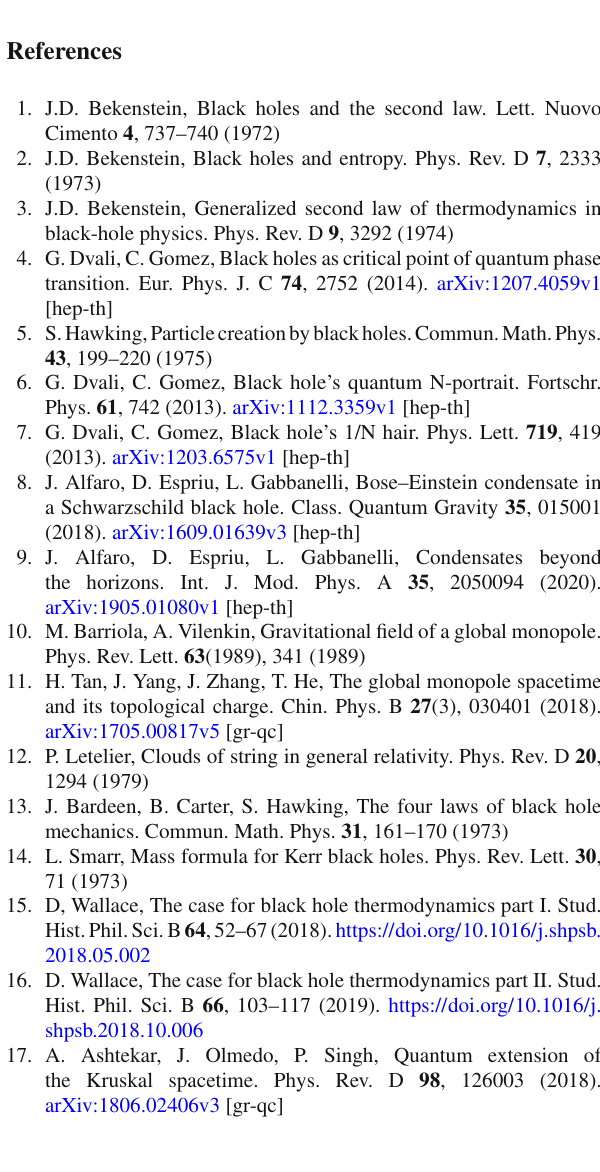
Fig. 2 In the graph on the left, we have 2 curves associated with the extremal black holes. In the graph on the right, we have open regions for non-extremal black holes. In the white regions, black holes solutions are not allowed because there are no real positive roots or the Hawking